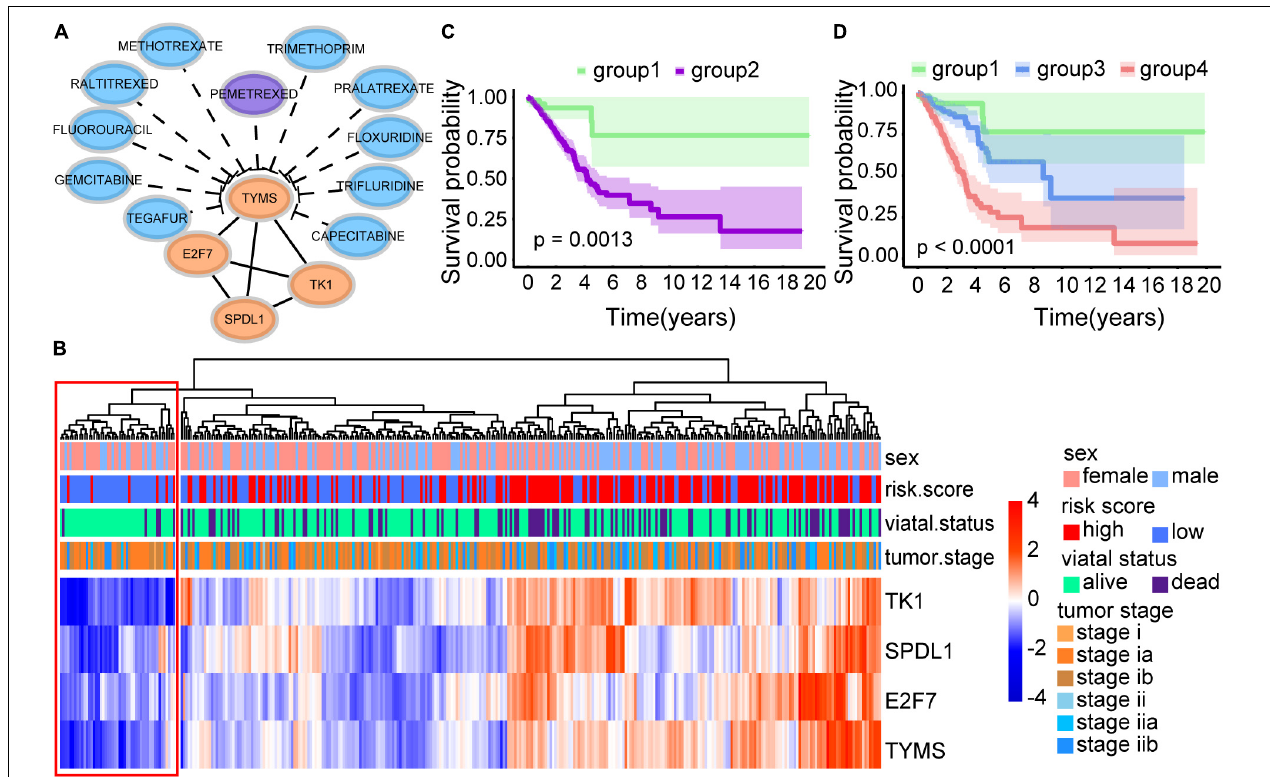
FIGURE 8 | Survival analysis of four immune-related biomarkers. (A) Interaction network of TYMS, E2F7, SPDL1, and TK1. TYMS is the target of the FDA-approved drug Pemetrexed. (B) Heatmap of CD8 T cell-related genes. (C) Kaplan–Meier survival curve. It showed the significant survival difference between patients with low expression of TYMS, E2F7, SPDL1, TK1 (group 1), and other patients (group 2). (D) Kaplan–Meier survival curve. Group 2 was further classified into group 3 and group 4 according to our defined risk score index. It displayed the significant survival difference among the three groups, including the low proliferation group (group 1), the high proliferation and low risk score group (group 3), and the high proliferation and high risk score group (group